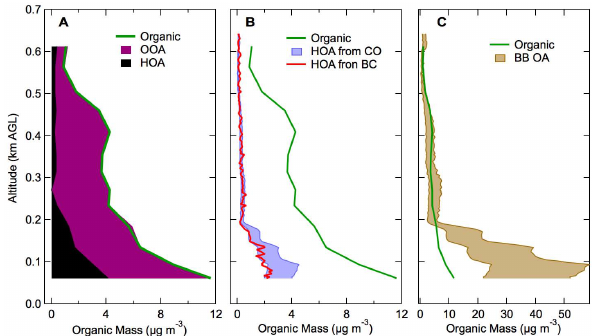
Fig. 14. Vertical profile from descent to Lone Star airfield on 12 Oc- tober showing (A) organic mass loading in comparison to OOA and HOA derived from the AMS the AMS; (B) organic mass loading compared to HOA derived from a parameterization against CO and black carbon (BC) for urban emissions (see text). (C) Organic mass loading compared to biomass burning emissions derived from CO if all of the CO enhancement above background were attributable to biomass burning (see